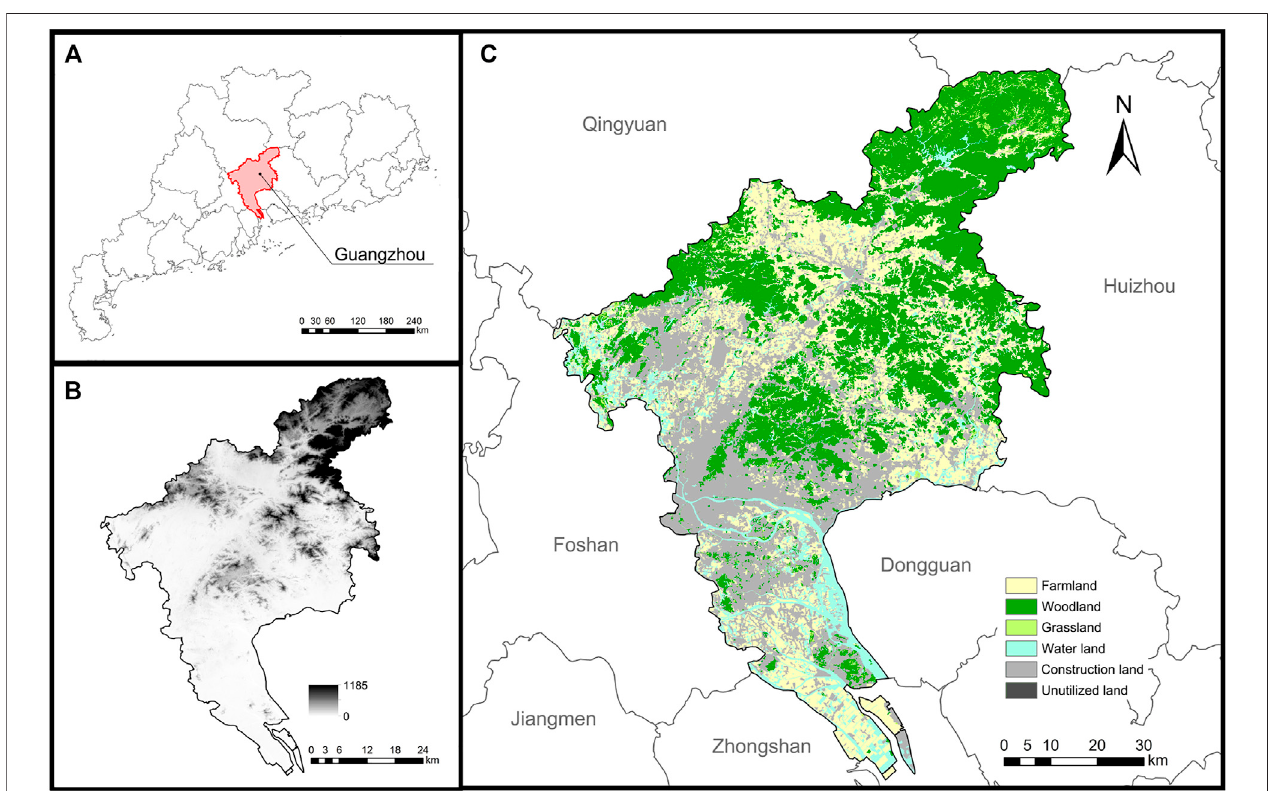
FIGURE 1 | (A) is the site of the study area, (B) is the elevation of the study area, (C) is land cover types of the study area.